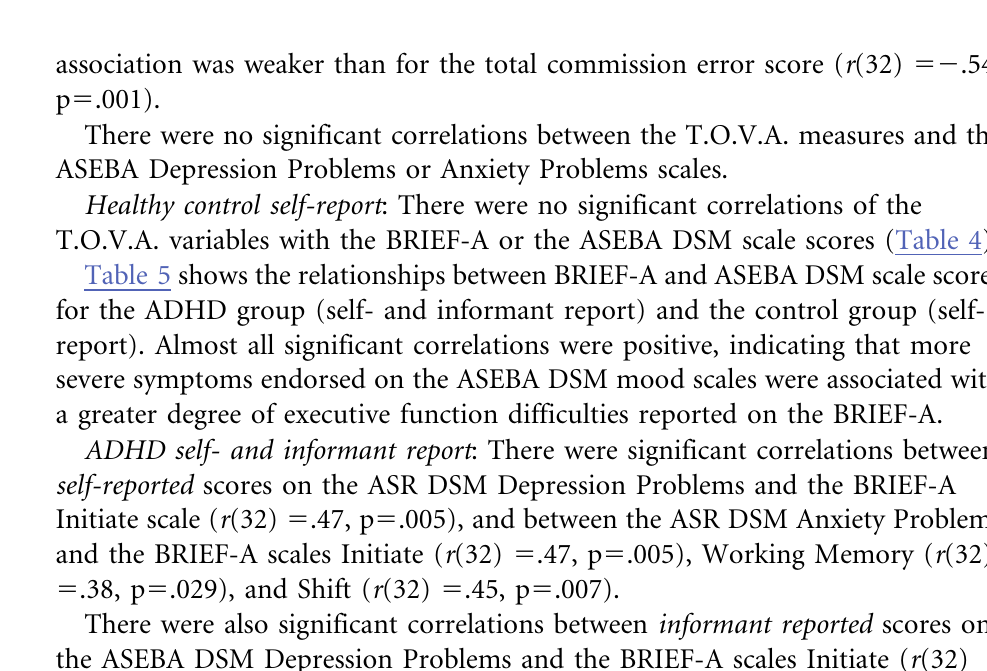
Organization of Materials